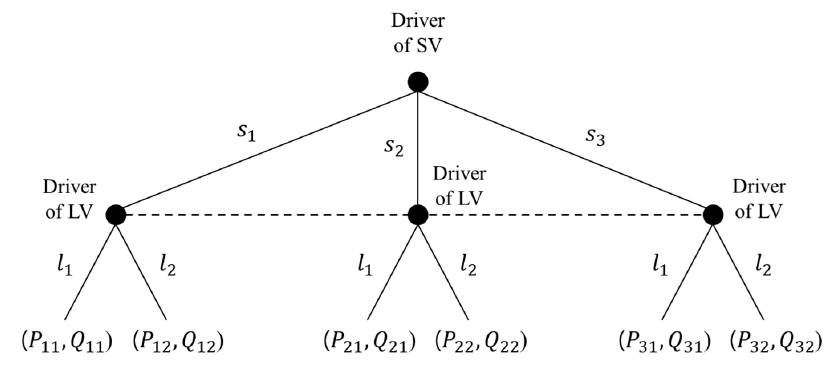
Figure 2. Merging decision-making game in the extensive form.